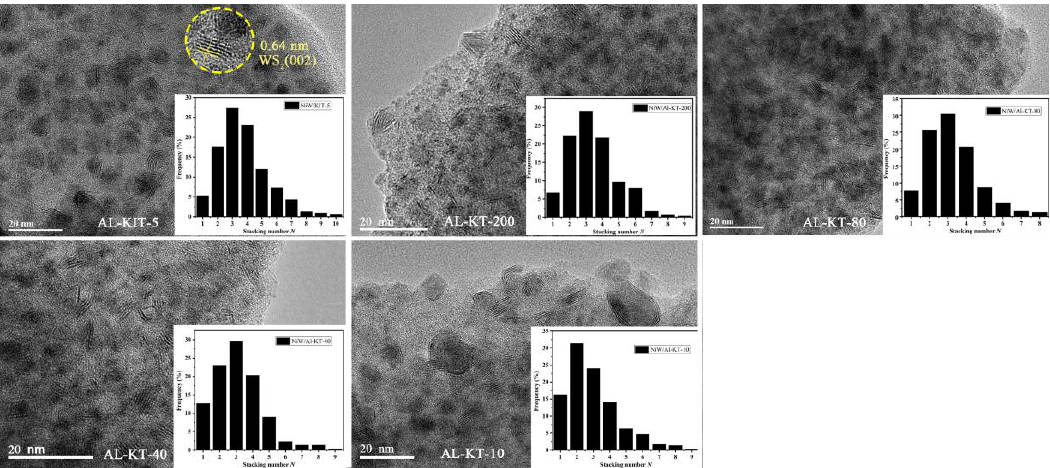
Figure 9. High-resolution transmission electron microscopy (HRTEM) micrographs of the sulfide catalysts.